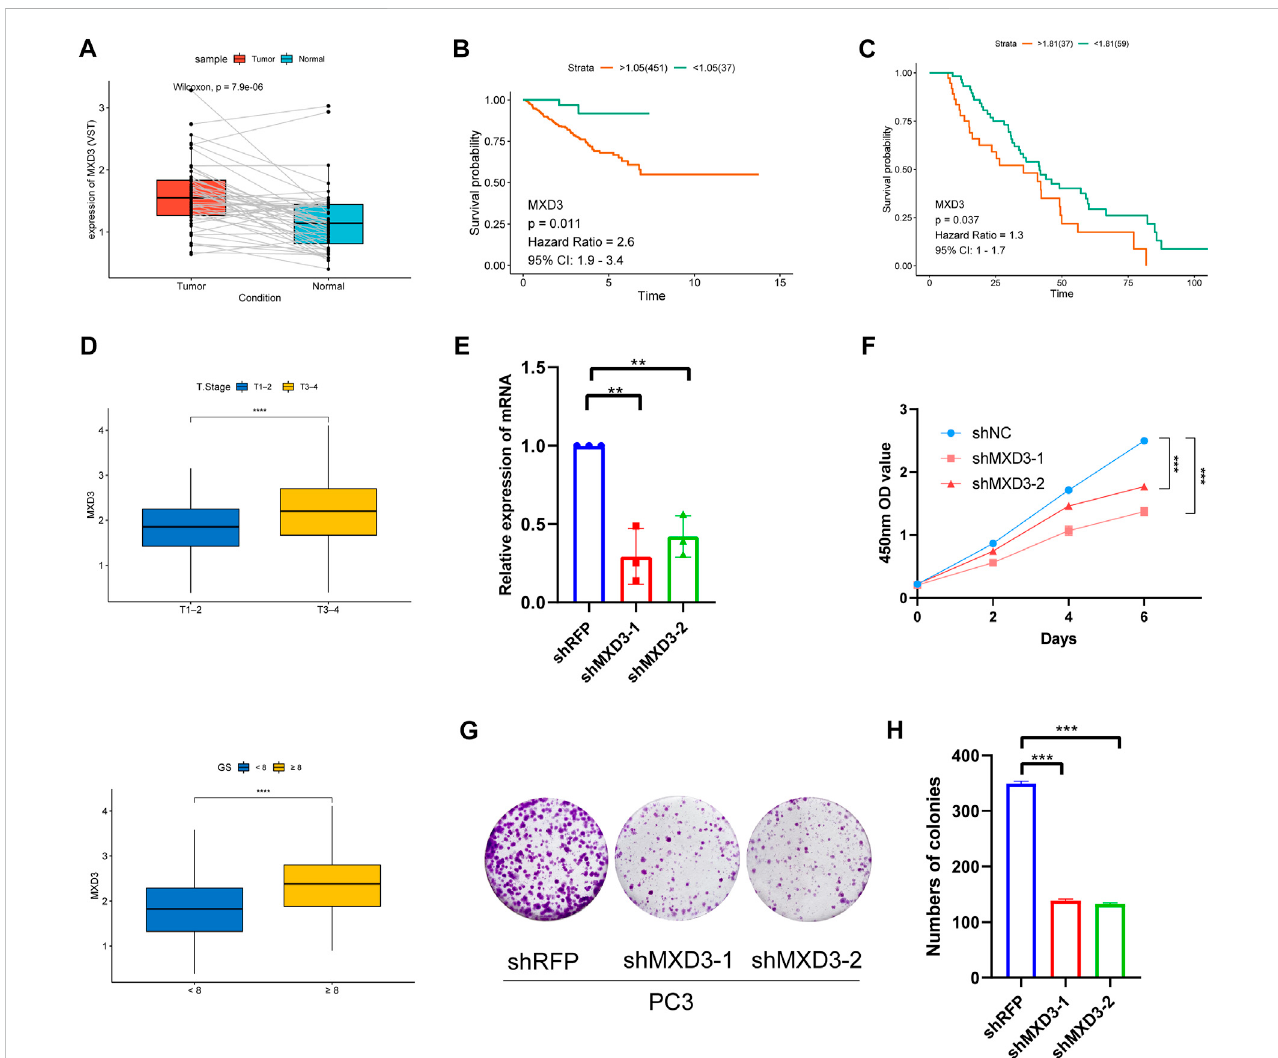
FIGURE 11 Clinical correlation analysis and in vitro experiment analysis of MXD3. (A) MXD3 expression in PCa paired tissues from the TCGA prostate adenocarcinoma (PRAD) dataset. (B) Kaplan-Meier curve of RFS (recurrence-free survival) in high and low MXD3 group in TCGA database. (C) Kaplan-Meier curve of OS (overall survival) for patients with high and low MXD3 expression in WCDT cohort. (D) Clinical correlation of MXD3 in TCGA prostate adenocarcinoma (PRAD) dataset. (E) PC3 cells were transfected with short hairpin RNAs targeting. The ef fi ciencies of the shRNAs were veri fi ed by real- time PCR. (F) CCK8 assays revealed that knockdown of MXD3 remarkably reduce the cell viability. (G) Inhibition of MXD3 reduced the colony numbers in the colony formation assay. (H) The numbers of colonies in each group were counted. Each value means the mean ± standard deviation of three independent experiments. *** p <